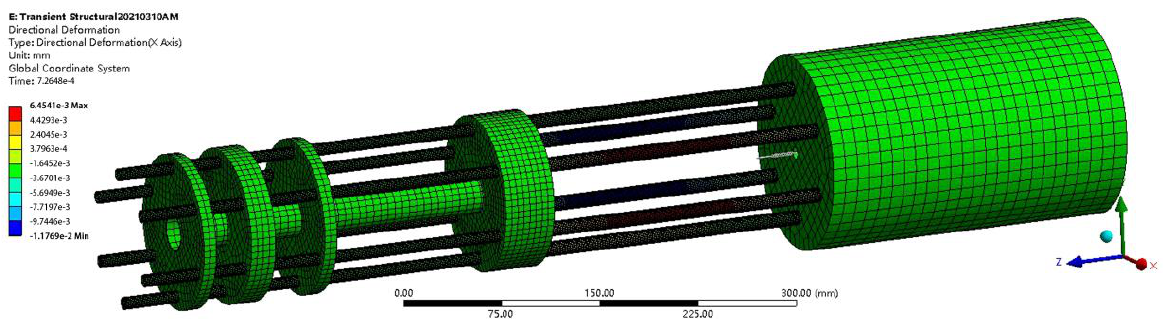
Figure 13. The X (transverse) displacement.